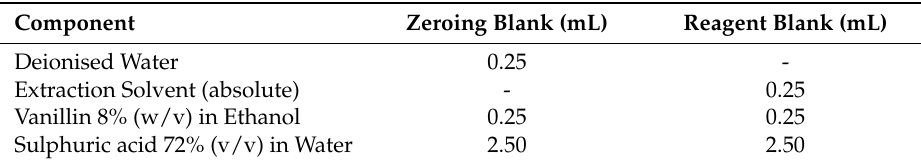
Table 2. The setup procedure for testing different extraction solvents in the reagent blank. Component Zeroing Blank